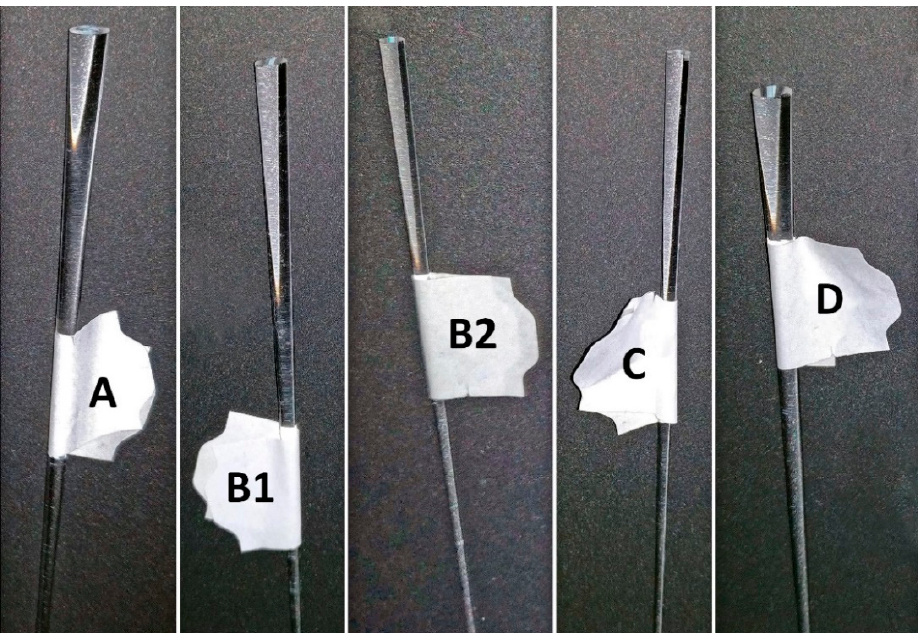
Figure 2. Photographs displaying the wider ends of the OFEs used in this study. Table 1. Designation of OFEs used in this study. OFEs were approximated using the